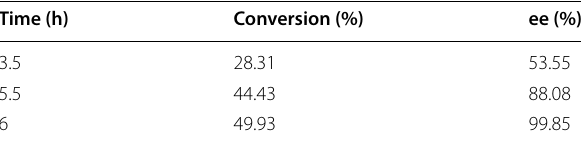
Table 5 Catalytic conversion of ( R )-α-MBA into acetophenone at different time periods Time